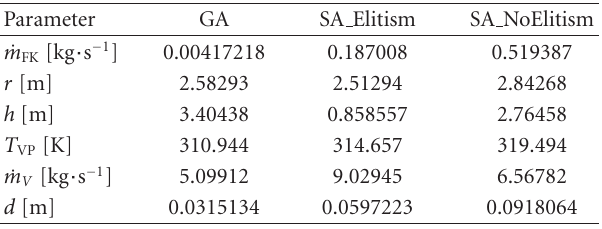
Table 2: DE parameter setting.